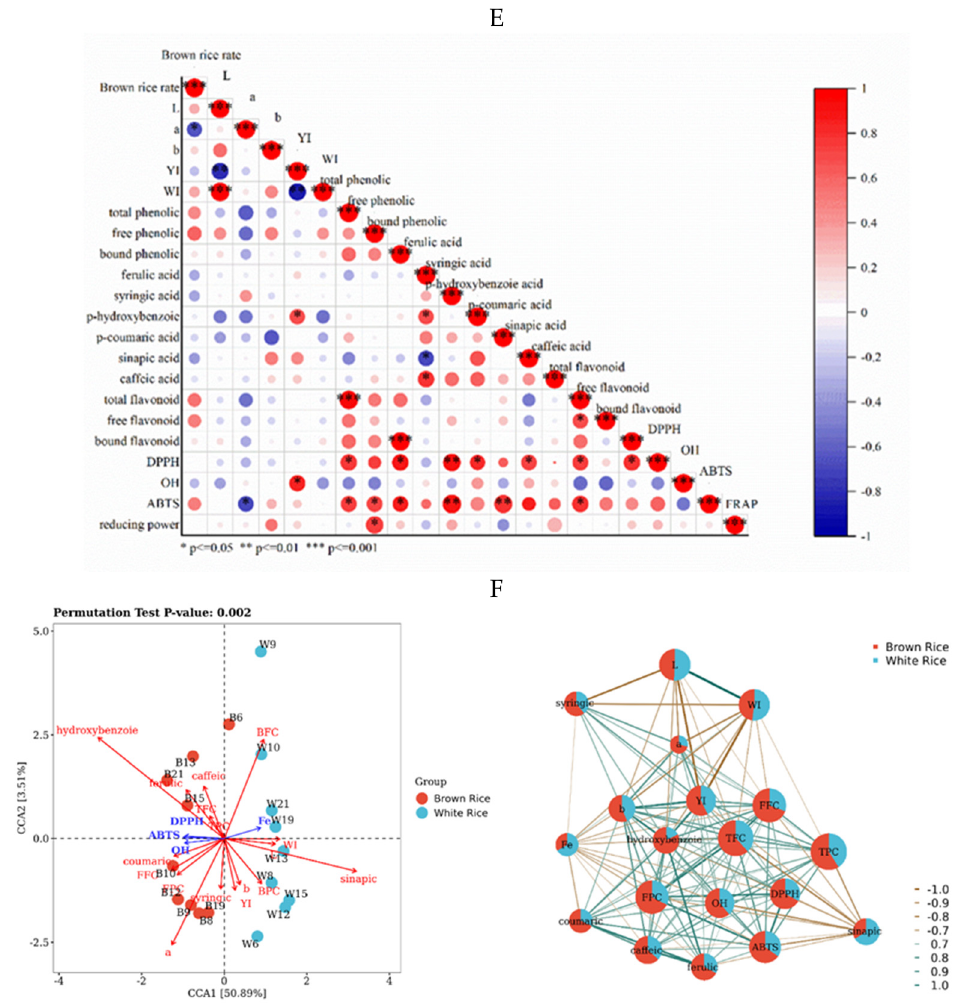
Figure 3. Antioxidant activity of nine japonica rice varieties (( A ): DPPH, ( B ): OH, ( C ): ABTS, ( D ): FRAP). Correlation between polyphenol composition and antioxidant activity ( E ). Canonical corresponence analysis and networks ( F ). Values of each bar with no letters in common are significantly different ( p < 0.05).